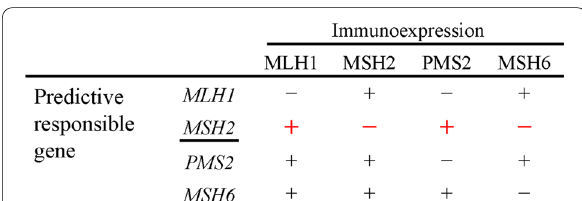
Fig. 4 The pattern of immunohistochemical staining for MMR protein. The red line was the pattern of this case. And the pattern suggested that predictive responsible gene of this case was